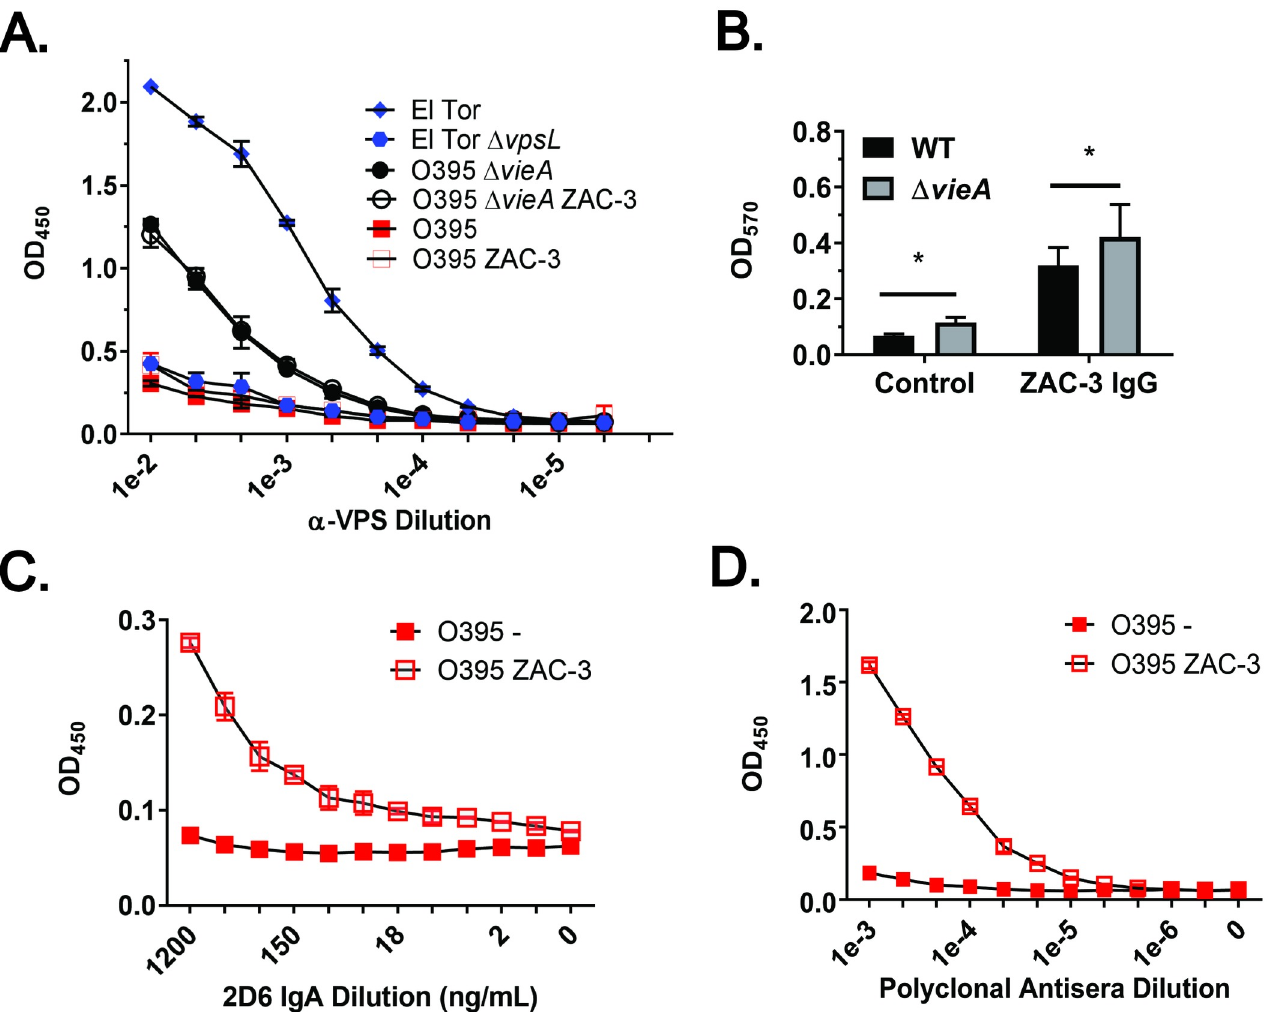
Fig 6. The ECM produced by V . cholerae O395 in response to ZAC-3 IgG is enriched in LPS, but not VPS. (A) VPS-specific ELISA of V . cholerae strains C6706, C6706 Δ vpsL ,O395, and O395 Δ vieA following 1 h treatment with SyH7 (an isotype control) or ZAC-3 IgG (9 μ g/mL). (B) Microtiter wells cultured with strains O395 and O395 Δ vieA treated for 1 h with SyH7 or ZAC-3 IgG, as described in Panel A, were subjected to straining with CV to detect relative ECM production. Stain O395 Δ vieA produced elevated levels of ECM compared to the wild type strain in the absence and presence of ZAC-3, as determined by two- way ANOVA followed by a Tukey multiple comparison test. (cid:3) ; P < 0.05. The graph constitutes three biological replicates with three technical replicates each. Anti-OSP (C) and anti-LPS (D) ELISA probed with 2D6 IgA or rabbit polyclonal antisera (BD Difco). The ZAC-3 treated cells exhibited higher OSP and LPS signals as compared to control cells, as determined by a one-way ANOVA followed by a Tukey multiple comparison test. The ELISAs are representative of three biological replicates with two technical replicates each.